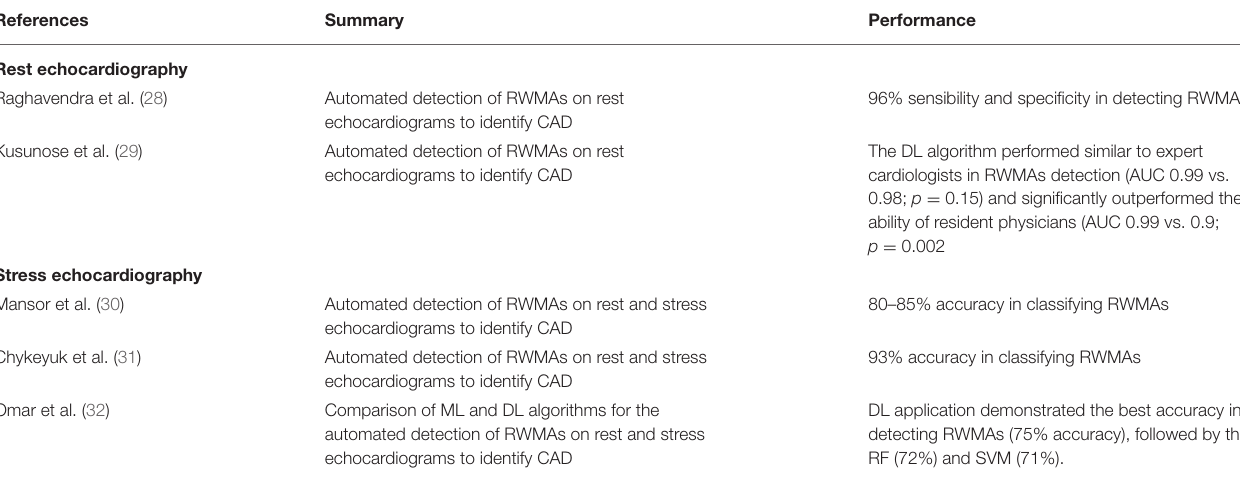
TABLE 2 | Main AI applications to rest and stress